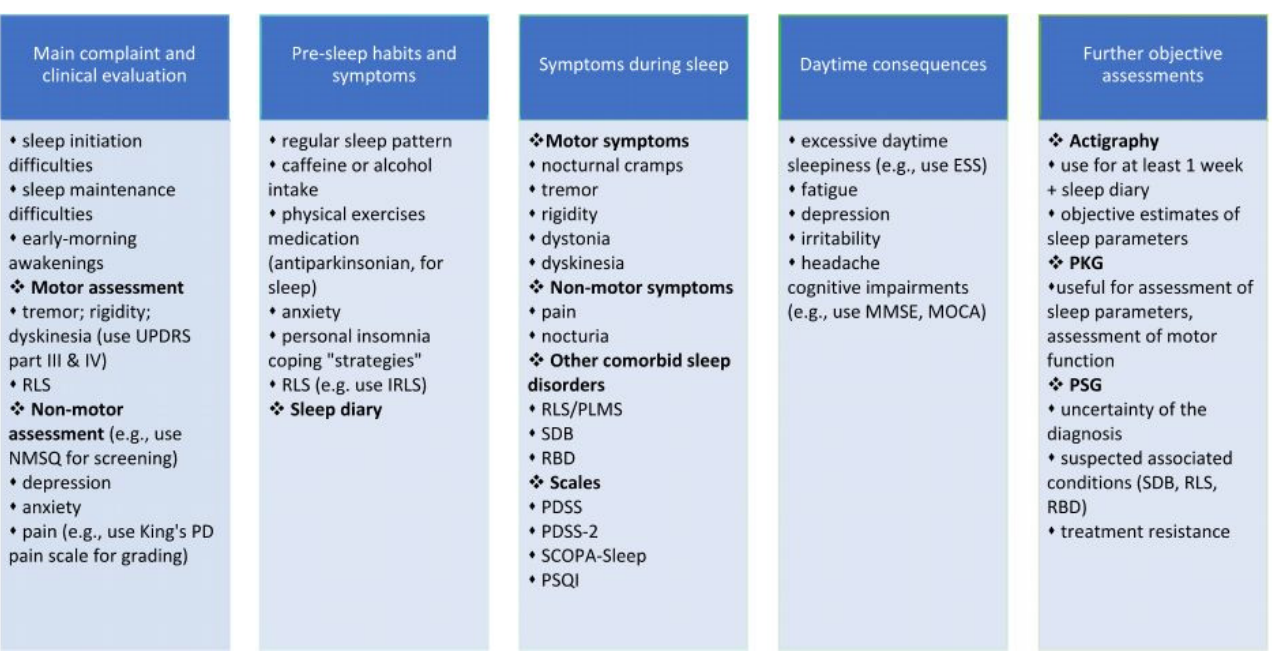
Figure 1. Proposed clinical interview components and subjective and objective methods for the personalized assessment of insomnia and sleep quality in PD patients. ESS, Epworth Sleepiness Scale; IRLS, International Restless Legs Syndrome Study Group rating scale; MMSE, Mini-Mental State Examination; MOCA, Montreal Cognitive Assessment; NMSQ, Non-Motor Symptoms Questionnaire; PD, Parkinson’s disease; PDSS, Parkinson Disease Sleep Scale; PKG, Parkinson’s KinetiGraph; PLMS, periodic limb movements of sleep; PSG, polysomnography; PSQI, Pittsburg Sleep Quality Index; RBD, REM sleep behavior disorder; RLS, restless legs syndrome; SCOPA, Scales for outcomes in PD; SDB, sleep-disordered breathing; UPDRS, Unified Parkinson Disease Rating Scale.